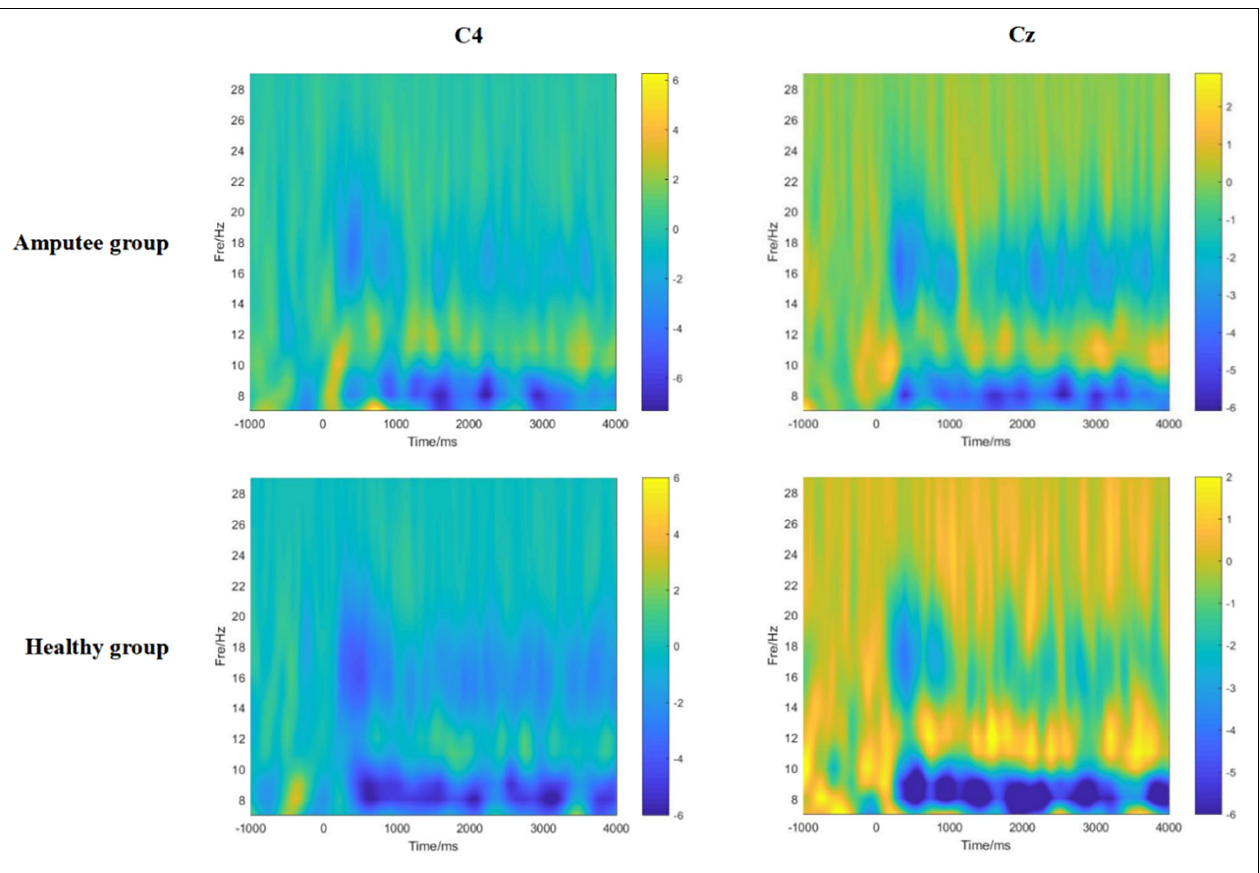
FIGURE 4 | The time-frequency diagrams of the primary motor cortex (C4, Cz) of amputees and healthy controls during the motor imagery task. A significant mu rhythm (7–12 Hz) and low beta frequency (13–20 Hz) after stimulation can be observed in both amputees and healthy controls.